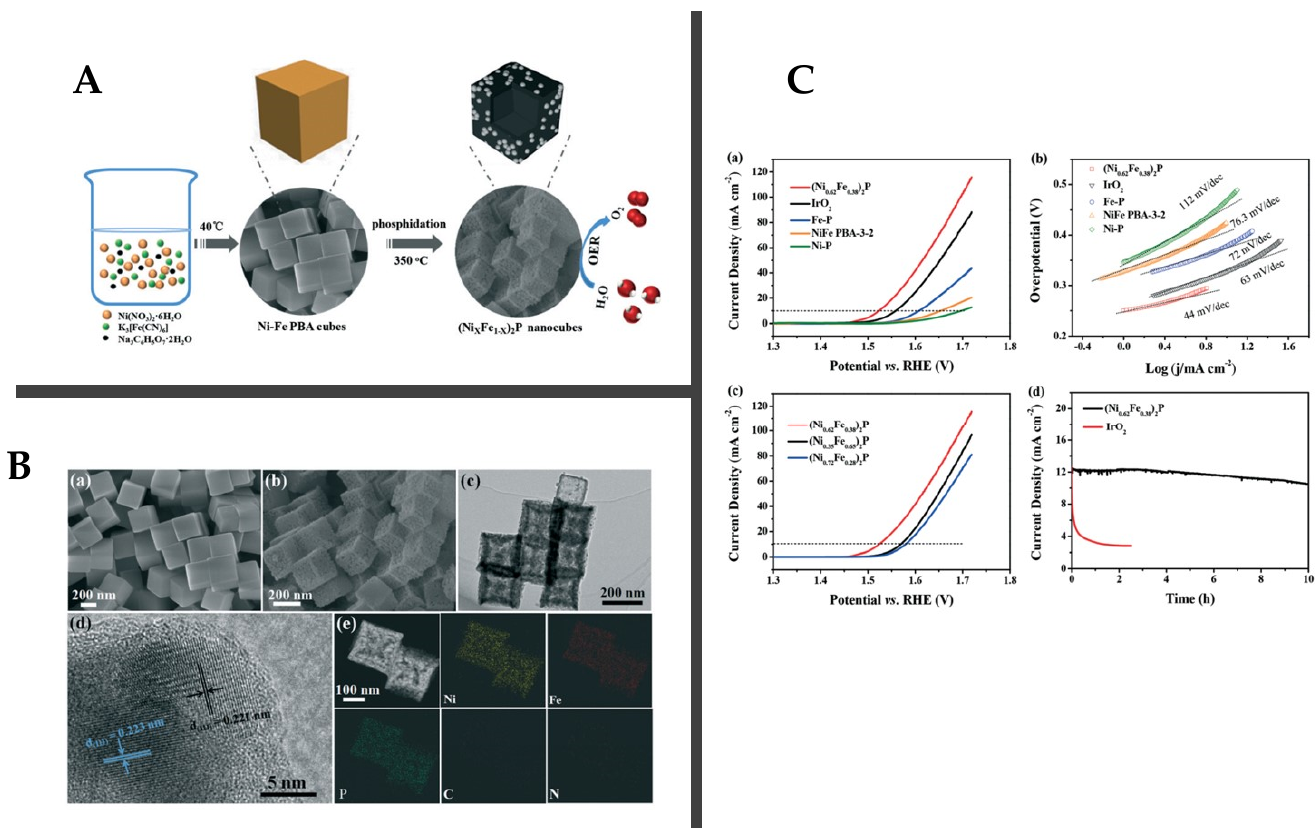
Figure 5. ( A ) Schematic illustration for preparation method, ( B ) corresponding TEM images ( a , b , c ), HTERM ( d ) and elemental mapping of the selected area ( e ) to describe the morphology, ( C ) as-prepared electrocatalyst with efficient oxygen evolution reaction (OER) performance ( a ), Tafel slope ( b ), and stability tests ( c , d ) respectively. Reprint from [154]. Copyright (2021), with permission from RSC.